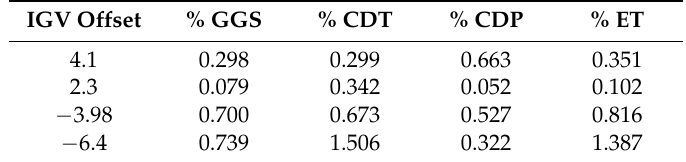
Table 7. Error between measured and simulated data for different IGV offset